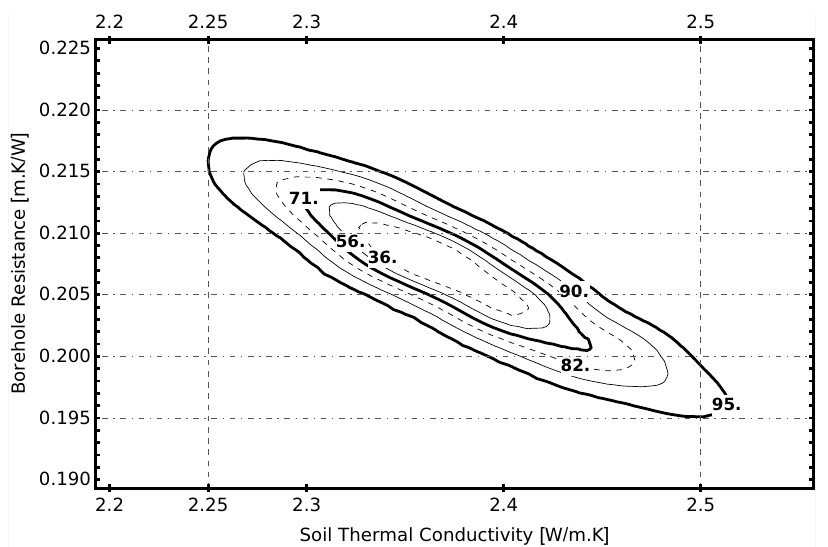
Figure 5. Probability density regions for λ , R b after 400 simulations of perturbed datasets for a temperature calibrated accuracy of ± 0.1 K and a flow sensor accuracy of ± 2%.